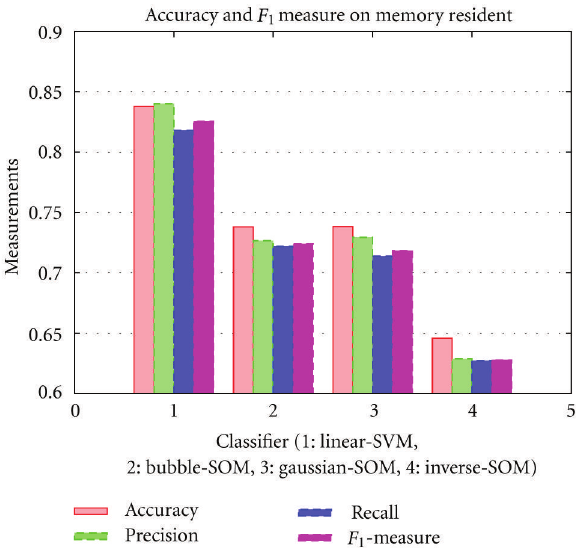
Figure 20: Classification performance on Memory Resident by di ff erent learners.